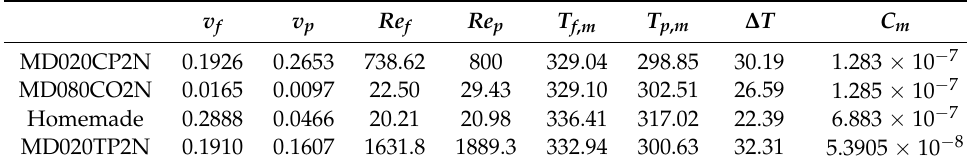
Table 4. Results of the transmembrane flux parameters at 70 ◦ C.